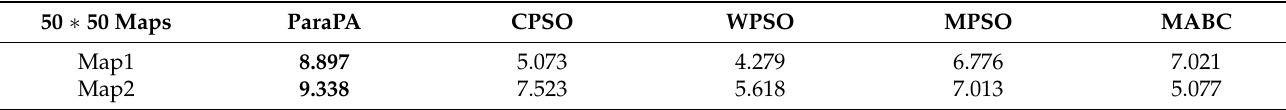
Table 4. Diversity of individuals ( DI ) on 50 × 50